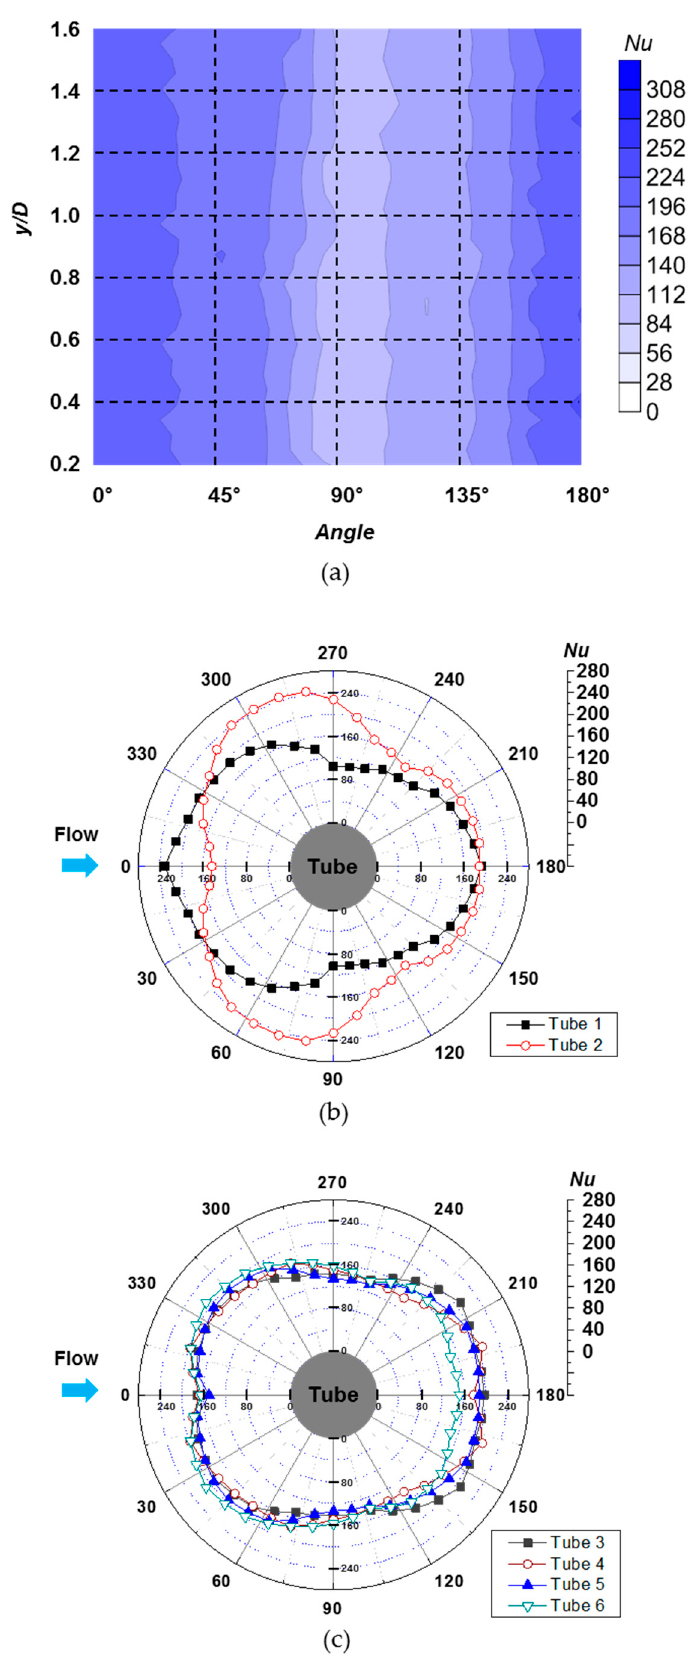
Figure 7. ( a ) Nusselt number distribution of Tube 1 at Re = 30,000, Vertically averaged Nusselt number; ( b ) Tubes 1 and 2; ( c ) Tubes 3–6.